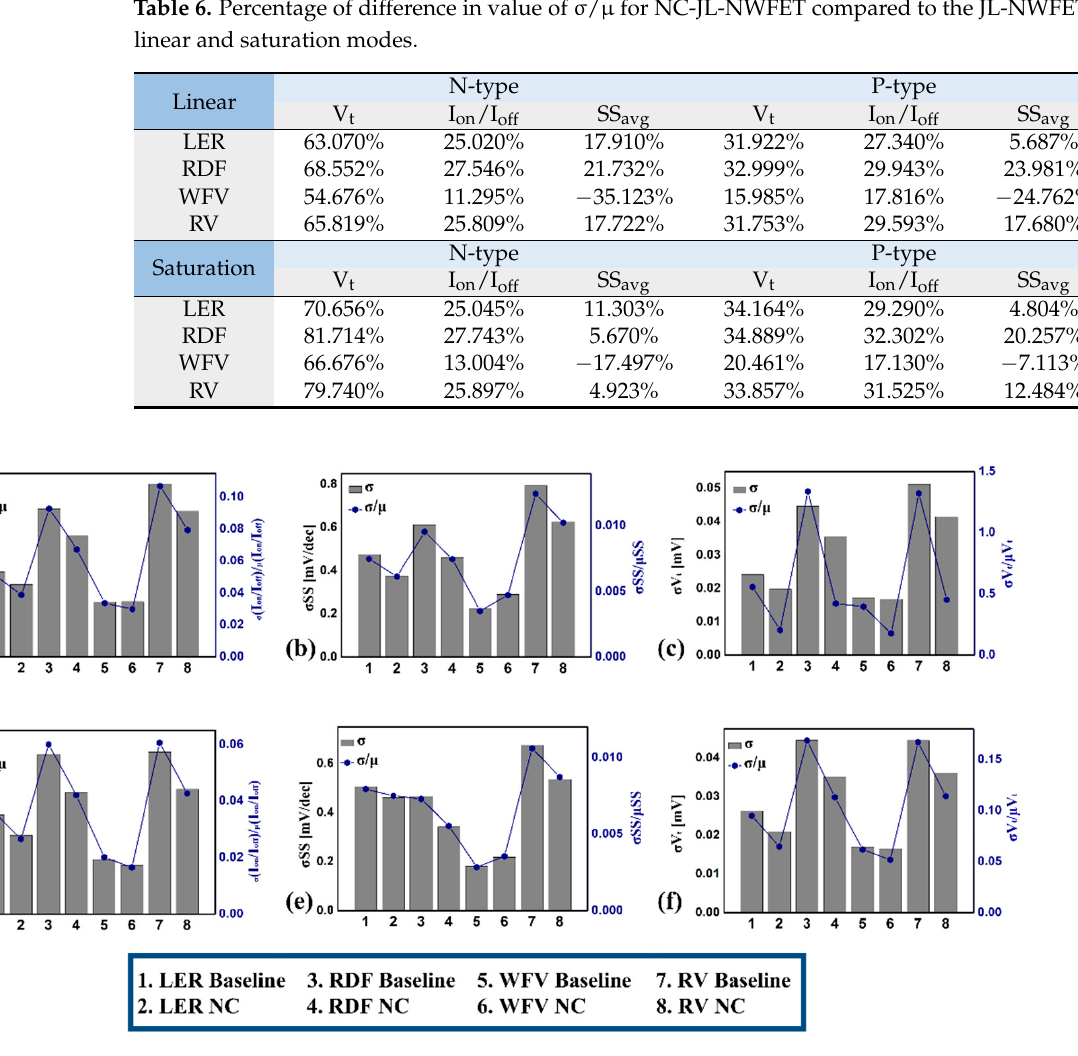
Table 6. Percentage of difference in value of σ /µ for NC-JL-NWFET compared to the JL-NWFET in linear and saturation modes.